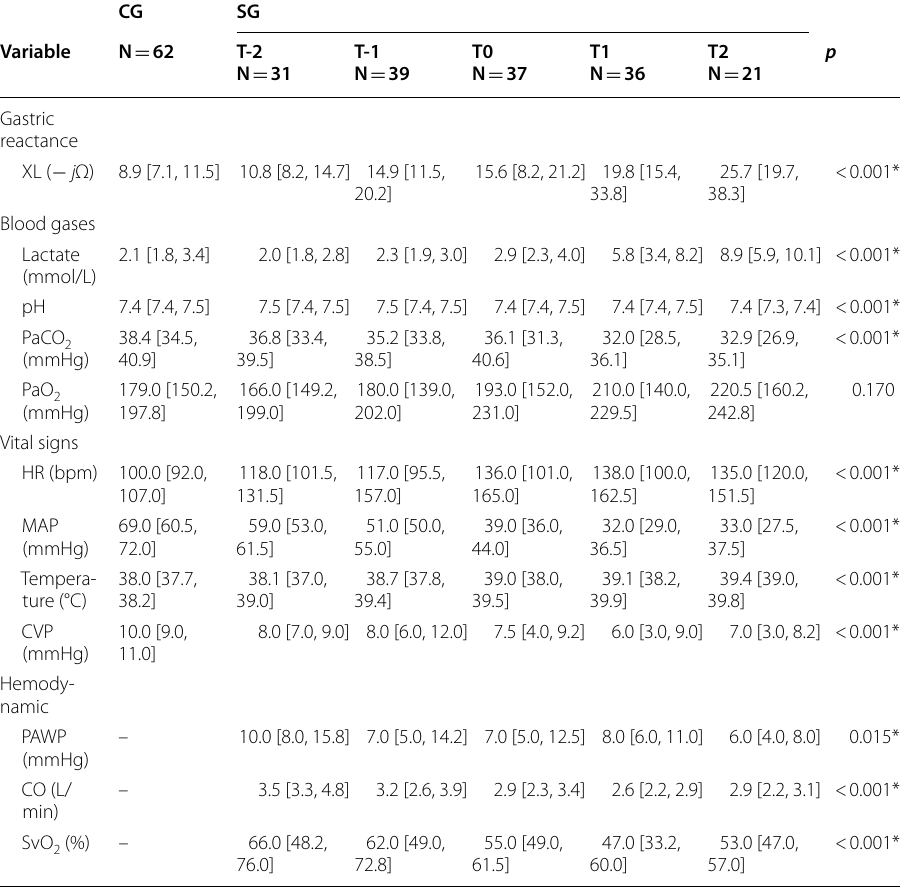
Table 1 Gastric reactance, blood gases, vital signs, and hemodynamic comparisons for the CG and the SG time